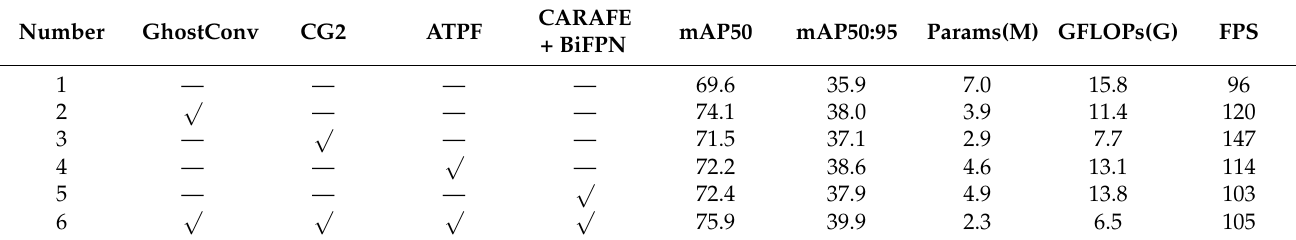
Table 1. Ablation experiments of CG-Net (NEU-DET